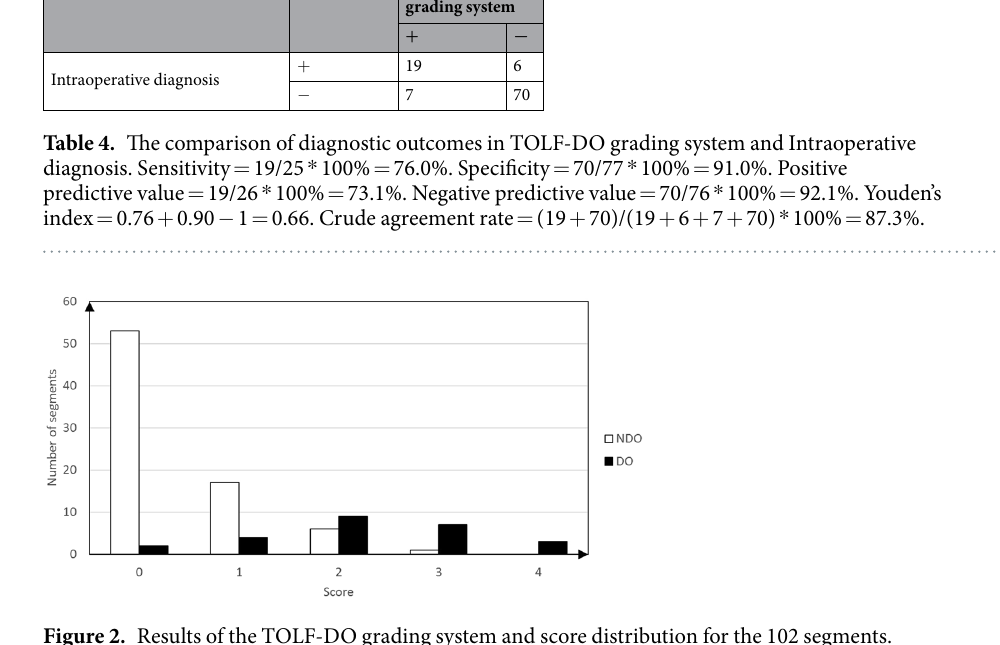
Figure 2. Results of the TOLF-DO grading system and score distribution for the 102 segments.